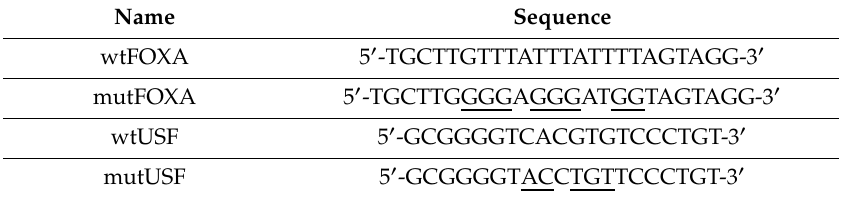
Table 1. List of primers used to generate the mutated FOXA and USF binding sequences. Name